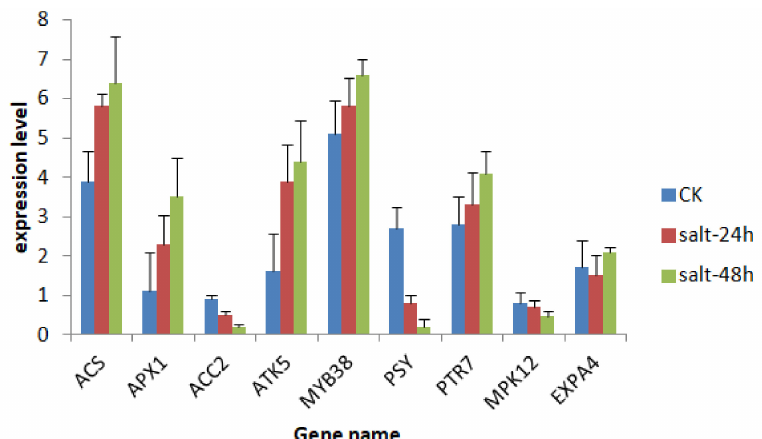
Figure 8. Bar plot showing the expression analysis of randomly selected RNA-Seq genes by quantitative polymerase chain reaction (qPCR). EF1-a gene was used as the reference gene for normalization of gene-expression data. Values are the average of three independent replicates. <1 is downregulation while >1 is